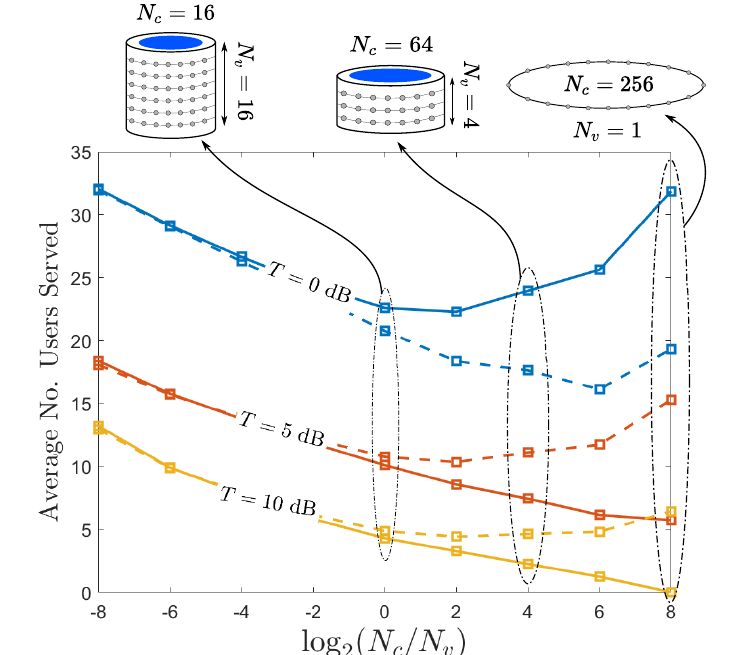
( N c / N v ) , within ¯ R = 50 m, 2 | = 1, λ = 5 × 0